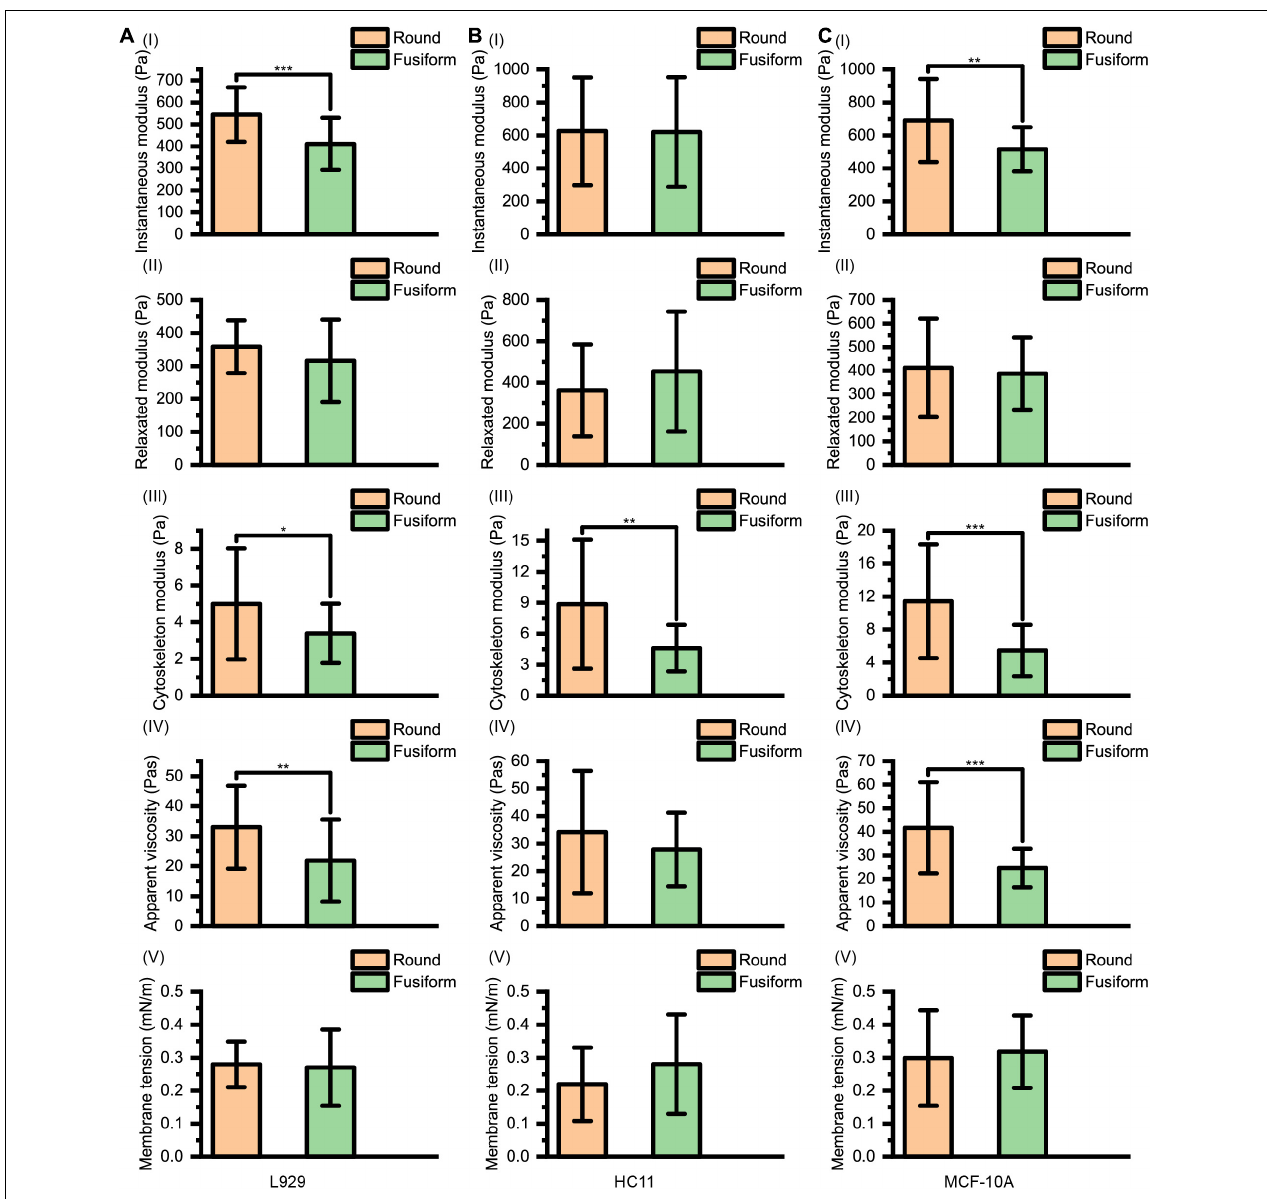
FIGURE 4 | Instantaneous modulus, relaxed modulus, cytoskeleton modulus, apparent viscosity, and membrane tension values for (A) L929, (B) HC11, and (C) MCF-10A cells with different adherent